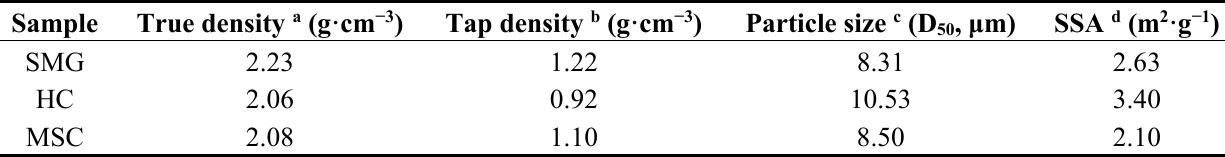
Table 1. Chara+9cteristics of the mesophase graphite (SMG), hard carbon (HC), and mesophase graphite (MSC) anode